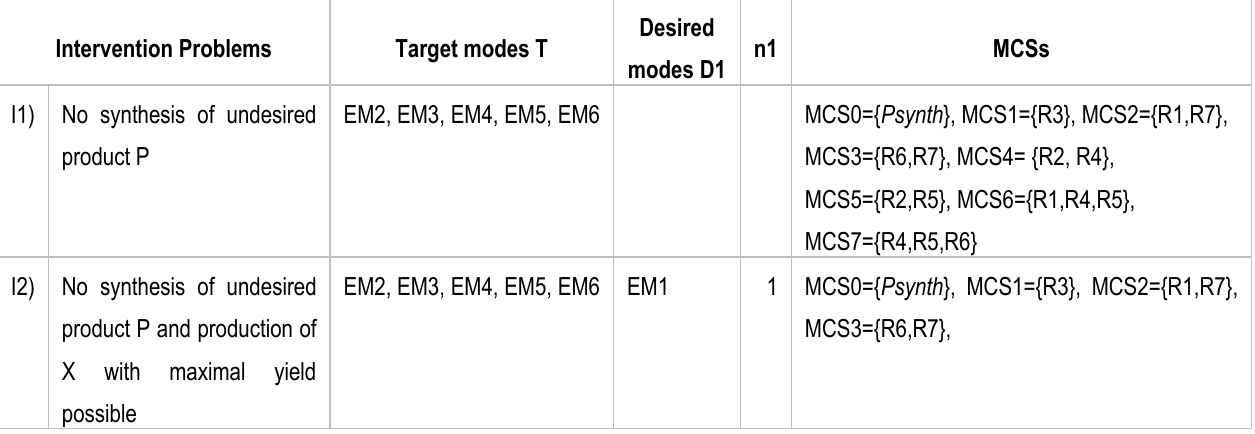
Table 2. Intervention problems and resulting MCSs for the example network,